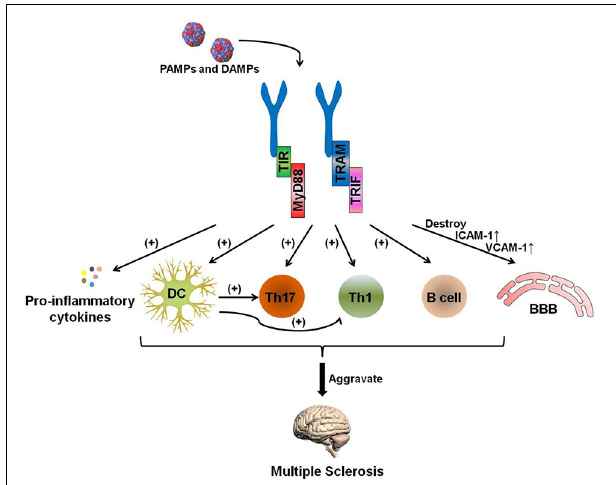
FIGURE 2 | The TLR-MyD88 signaling pathway contributes to the pathogenesis of multiple sclerosis (MS). The TLR-MyD88 and TLR-TRIF signaling pathways activate dendritic cells (DCs), Th17 cells, Th1 cells, and B cells and increase pro-inflammatory cytokine secretion. These pathogenic DCs can also promote the activation of Th1 and Th17 cells. Furthermore, the TLR signaling pathway destroys the blood brain barrier (BBB) and increases the expression of BBB-expressed adhesion molecules [ICAM-1 and vascular cell adhesion molecules (VCAM)-1] after being stimulated by PAMPs and endogenous danger-associated molecular patterns (DAMPs). The activation of these cells and the destruction of the BBB aggravate